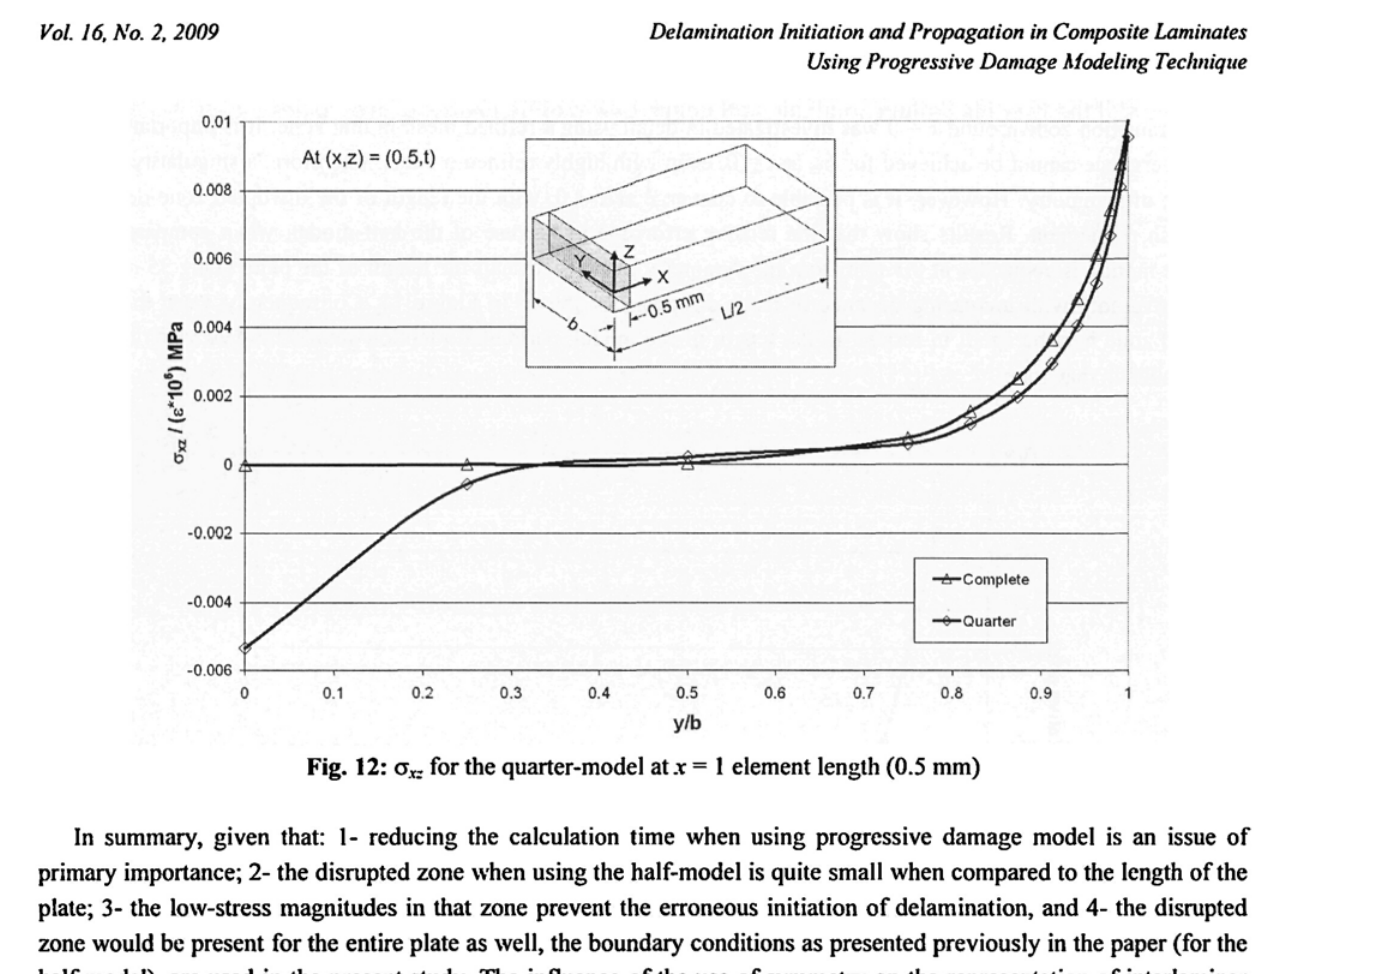
Summary of the influence of using symmetry